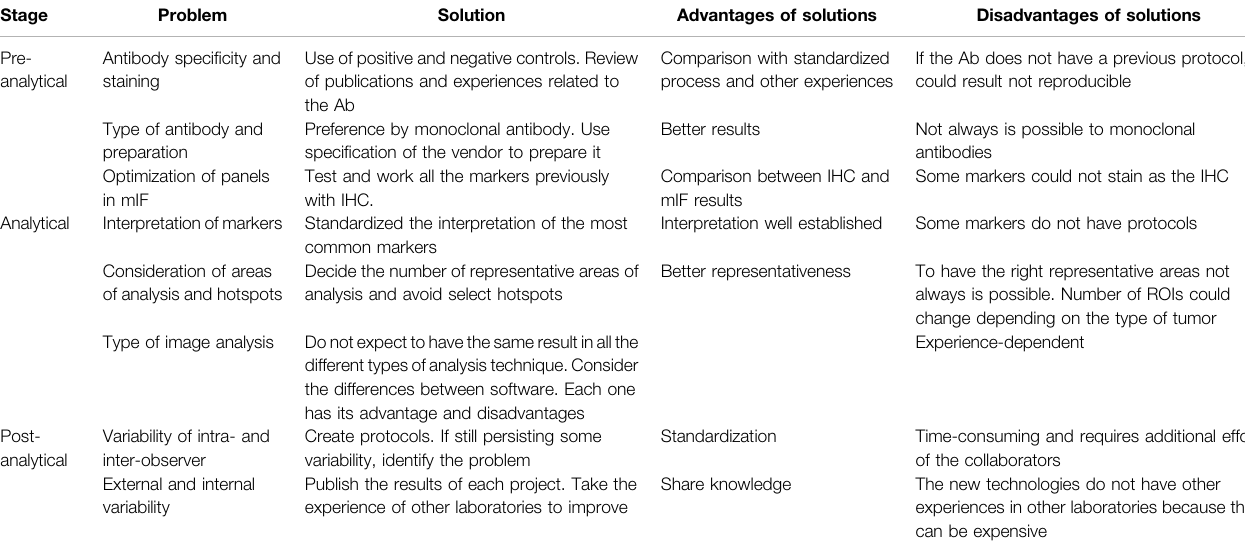
TABLE 4 | Stages, challenge, and possible solutions for the best reproducibility of multiplex immuno fl uorescence panel.